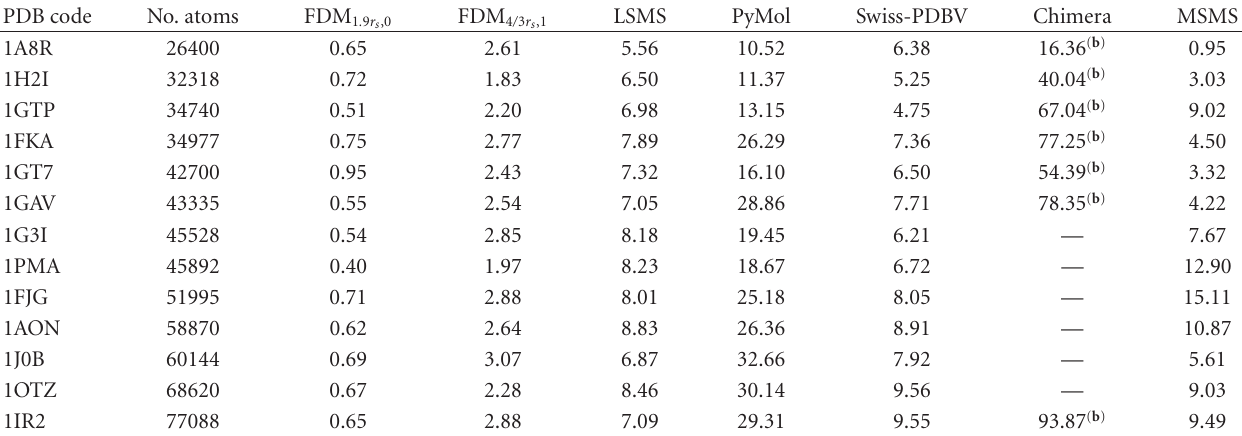
Table 1: Computation times (in s) for di ff erent methods. ( ( b ) from [32].)